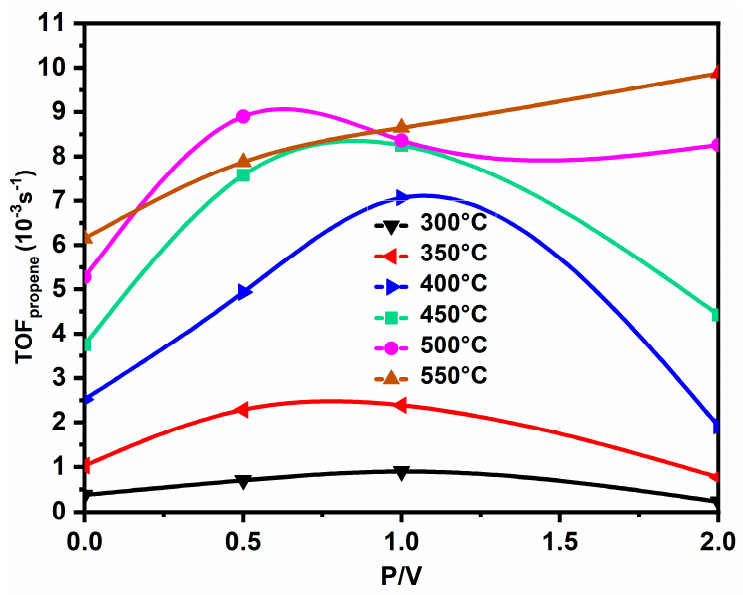
Figure 16. Propene yield TOF variation of 3.6 wt%V 2 O 5 / ZrO 2 modified phosphate catalysts in air mixture depending on P/V ratio and temperature.